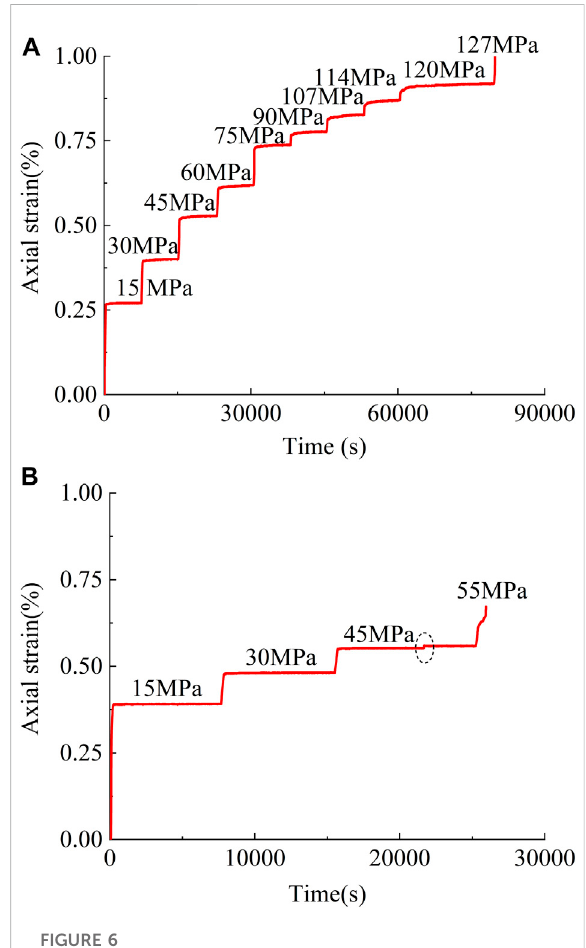
FIGURE 6 Creep curves of sandstone specimen under multi-step loading. (A) Intact specimen, and (B) prefabricated fi ssures